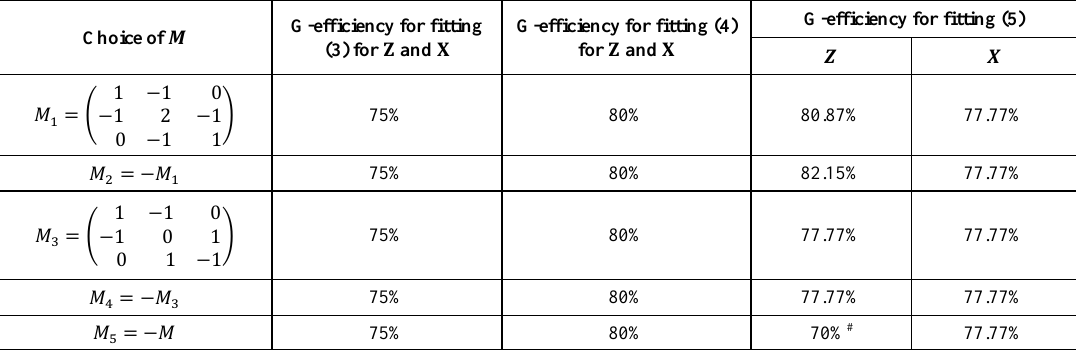
Table 1. G-efficiency of unconstrained and constrained mixture designs corresponding to different choices of 𝑀 for fitting Scheffé’s canonical polynomials G-efficiency for fitting G-efficiency for fitting G-efficiency for fitting (4) Choice of 𝑴 (3) for 𝐙 and 𝐗 for 𝐙 and 𝐗